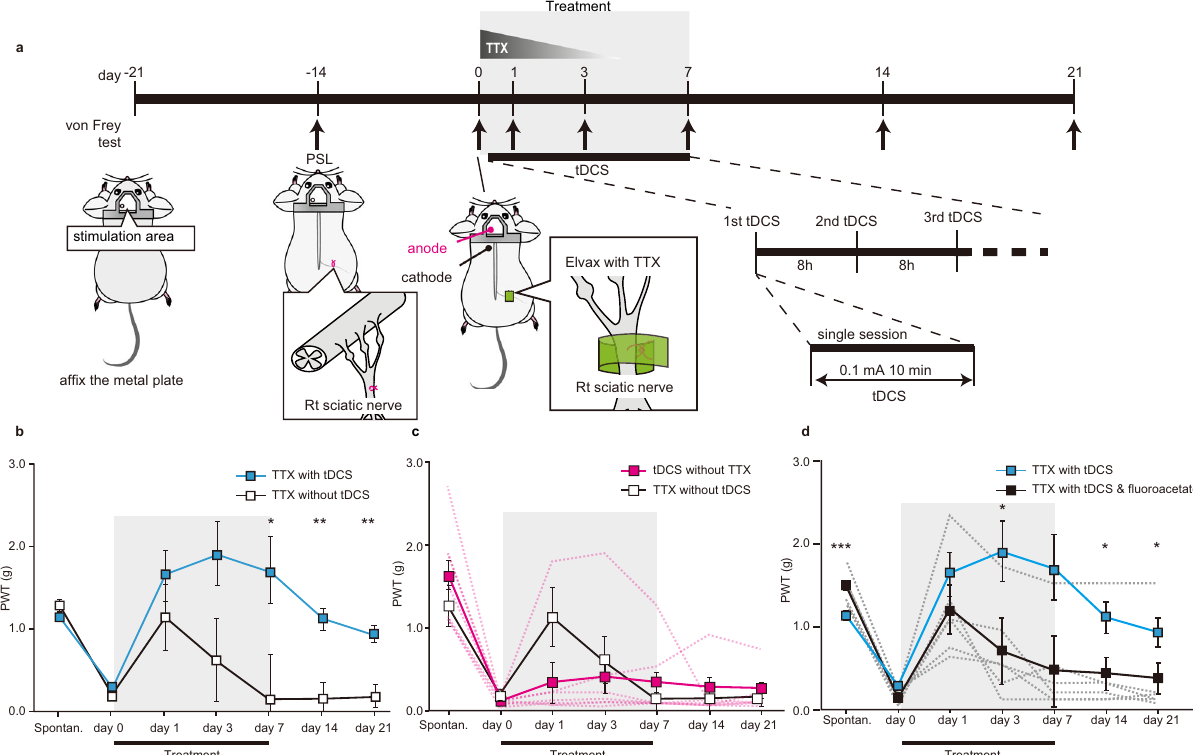
Fig. 1 Astrocyte activation by transcranial direct current stimulation (tDCS) combined with transient nerve block reverses mechanical allodynia-like behaviour. a Schematic of the experimental schedule. The start of tDCS-TTX (or control) treatment was designated as “ day 0 ” . Surgery for head-plate fi xation and PSL at the right hind limb were performed at day-21 and day-14, respectively. Mechanical paw withdrawal thresholds (von Frey) were measured (arrows) before injury (day-14), and before (day 0), during (day 0 – day 7), and after (day 8 onwards) treatment. tDCS (black bar) for activating astrocytes (constant 0.1 mA current for 10 min, see Supplementary Fig. 1 for more detail) was administered at 8-hourly intervals from day 0 to day 7 (21 sessions in total). TTX (graded triangle) was continuously administered to the injured right sciatic nerve via elution from an Elvax cuff preparation from day 0 to day 5. b – d Graphs plotting mechanical paw withdrawal thresholds as mean ± SEM at various time-points before PSL (Spontan.), and before (day 0), during (day 1 – day 7) and after (day 8 onwards) the TTX with tDCS treatment period (grey shading) or various other control treatments. Dashed-lines represent individual mice. For all graphs separately, statistical signi fi cance was tested using a two-way repeated measures ANOVA, followed by Bonferroni post-hoc tests comparing treatment cohorts at each time-point, * p < 0.05, ** p < 0.01, *** p < 0.001. Source data are provided as a Source Data fi le. b Combined TTX with tDCS treatment (blue, n = 7 mice), but not TTX treatment alone (white, n = 4 mice), reversed mechanical allodynia-like behaviour, with mechanical paw withdrawal thresholds returning to pre-PSL levels (see Supplementary Fig. 4a for values from individual mice). c Separate administration of tDCS (magenta, n = 8 mice) failed to reverse mechanical allodynia-like behaviour. Note the TTX without tDCS data (white, n = 4 mice) in this panel replots the same data as shown in ( b ) for comparison. d tDCS with TTX & fl uoroacetate (black, n = 6 mice) failed to reverse mechanical allodynia-like behaviour. Elvax with fl uoroacetate was applied onto S1 on day 0. Note the TTX with tDCS data (blue, n = 7 mice) in this panel replots the same data as shown in ( b ) of L1-3 astrocytes in S1 (based on a sample of 392 astrocytes from 5 mice). A single intraperitoneal injection of clozapine N-oxide (CNO; 1.0 mg/kg, i.p.), which activates this hM3Dq receptor, also